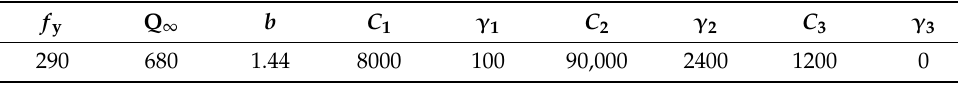
Table 2. Parameters of the combined hardening model.